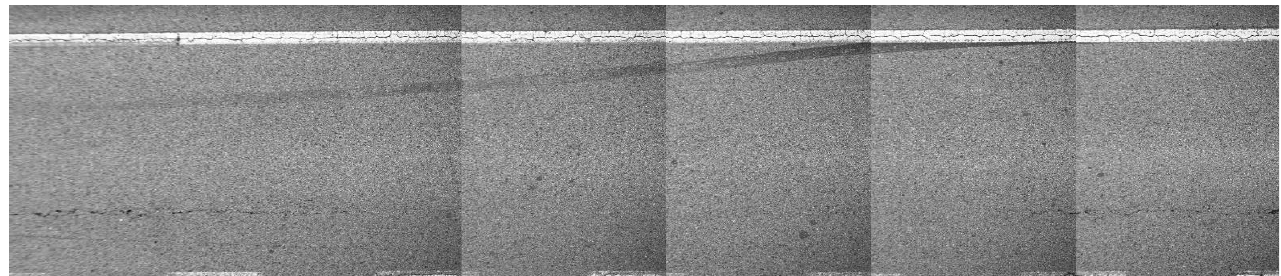
Figure 10. Road section generated through the image concatenation method.